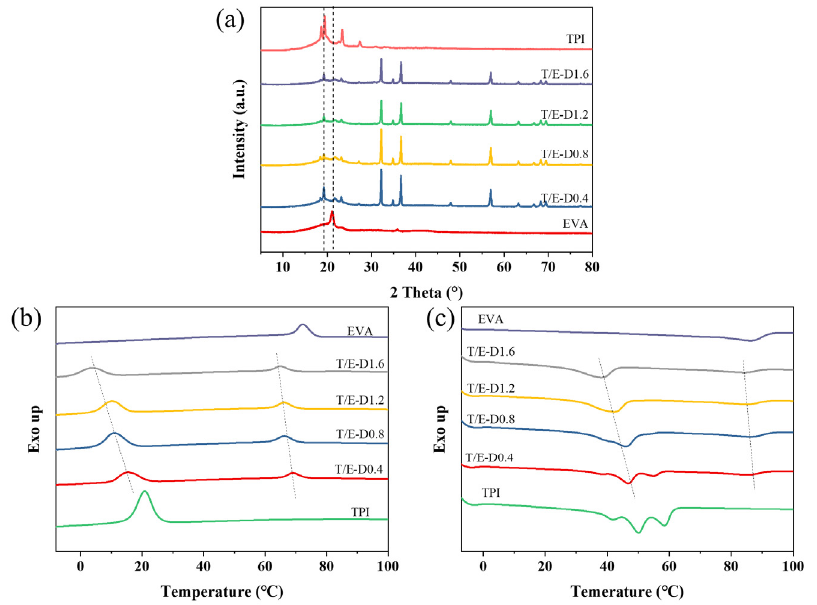
Figure 3. ( a ) X-ray diffractogram curves, ( b ) DSC cooling curves, and ( c ) secondary heating curves of the TPI/EVA composites.